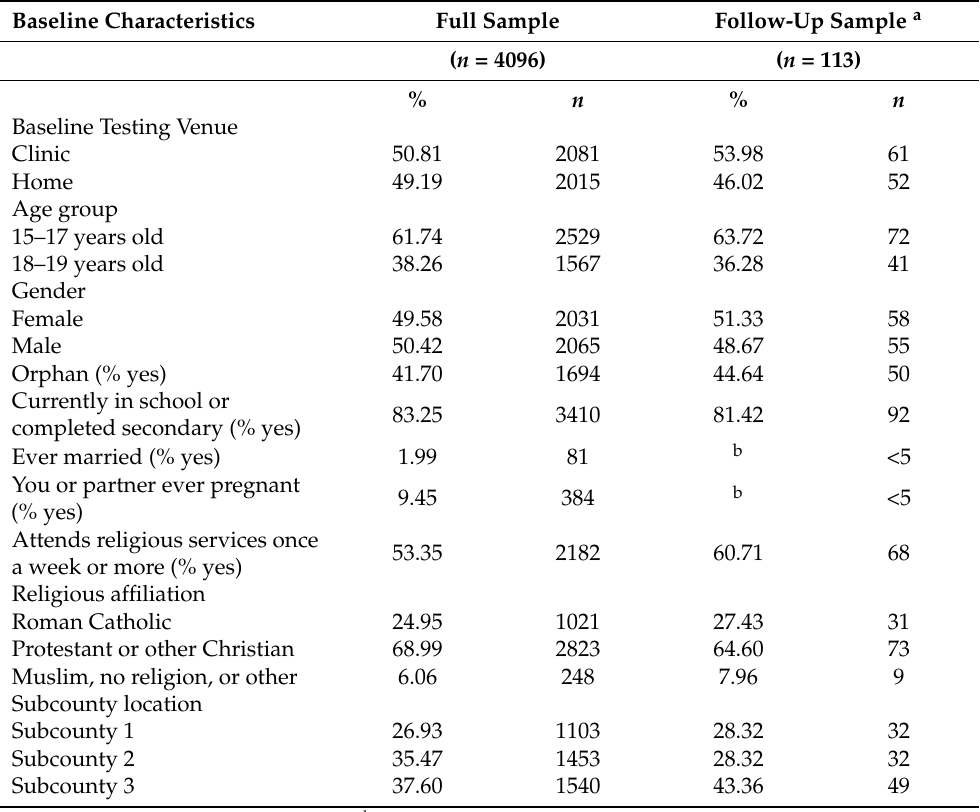
Table 1. Baseline Characteristics of Full Sample and Follow-up